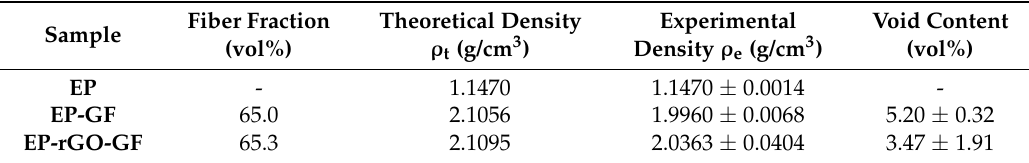
Table 3. Density, porosity, and fiber content of the prepared composites.